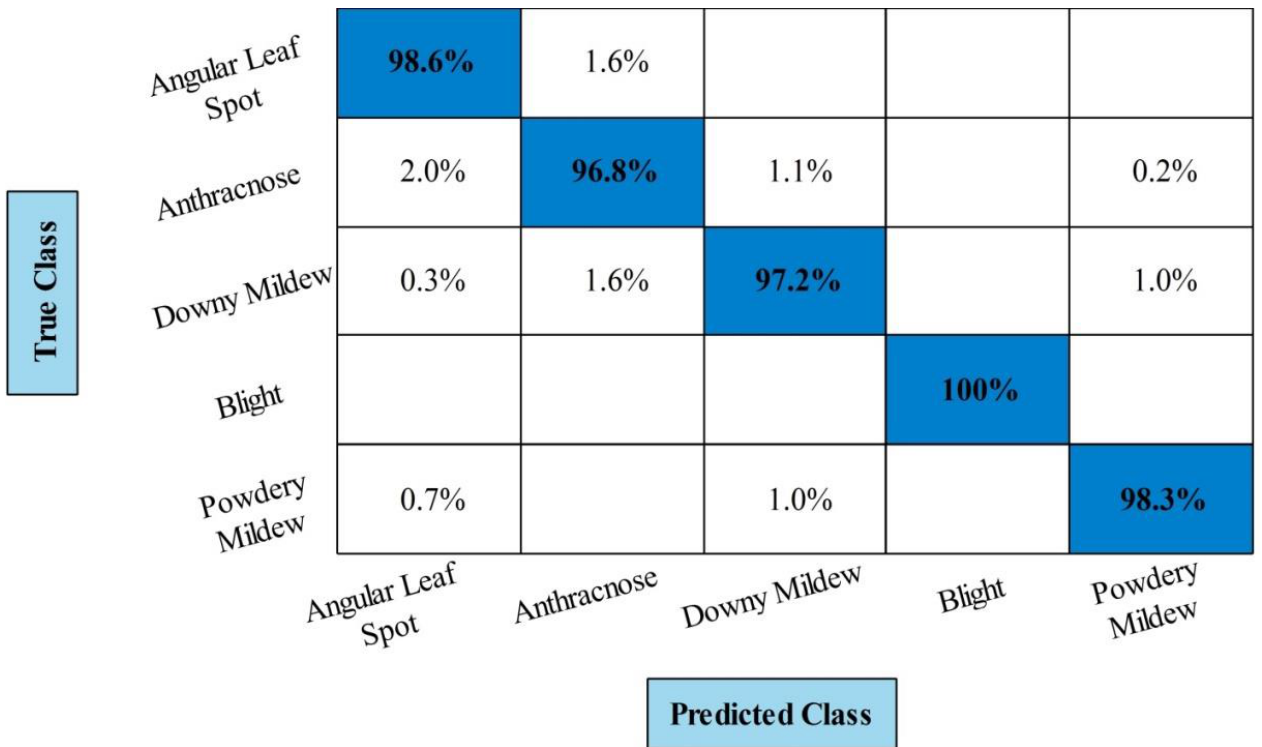
Figure 7. Confusion matrix of Cubic SVM after parallel fusion of all selected pre-trained deep features and Entropy-ELM selection.